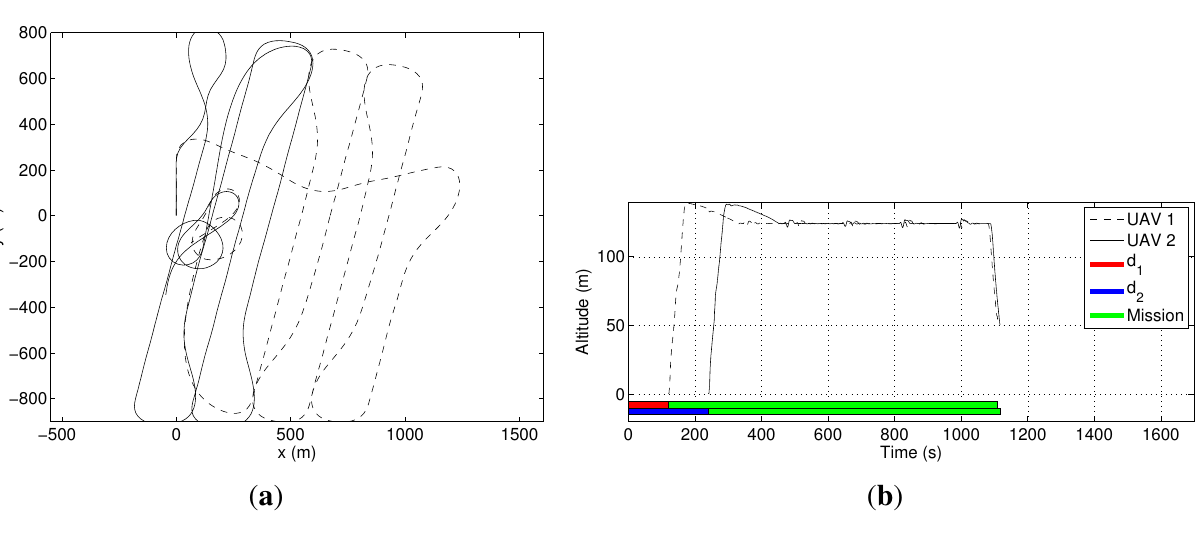
Figure 15. Coverage of the area in Figure 12 with two UAVs and a smaller setup time. ( a ) The UAVs’ paths projected on a cartographic reference system; ( b ) The UAVs’